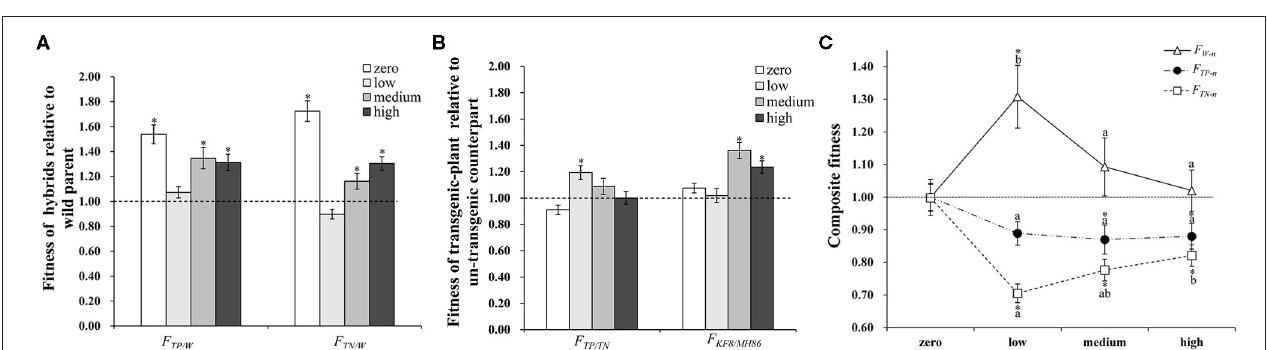
FIGURE 2 | (A) The composite fitness of TP and TN relative to W ( F TP / W and F TN / W ). (B) The composite fitness of transgenic plant relative to its non-transgenic counterpart ( F TP / TN and F KF 8 / MH 86 ). (C) The composite fitness of transgenic and non-transgenic hybrids (TP and TN) and the wild parent (W) under insect pressure relative to conditions without insect pressure ( F W − n , F TP − n , F TN − n ), different letters denote their significant differences ( P < 0.05) under three insect pressures using the Duncan’s multiple range test. Bars represent standard error. Asterisk indicates the fitness value is significantly different from 1.00 based on the t -test ( P < 0.05).